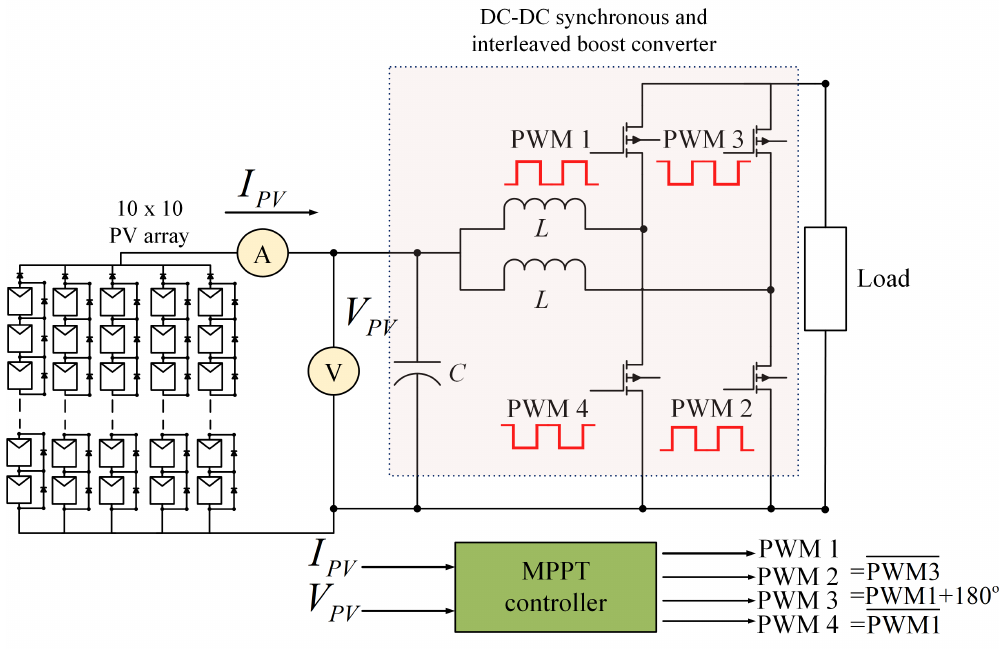
Figure 10. System diagram for MPPT